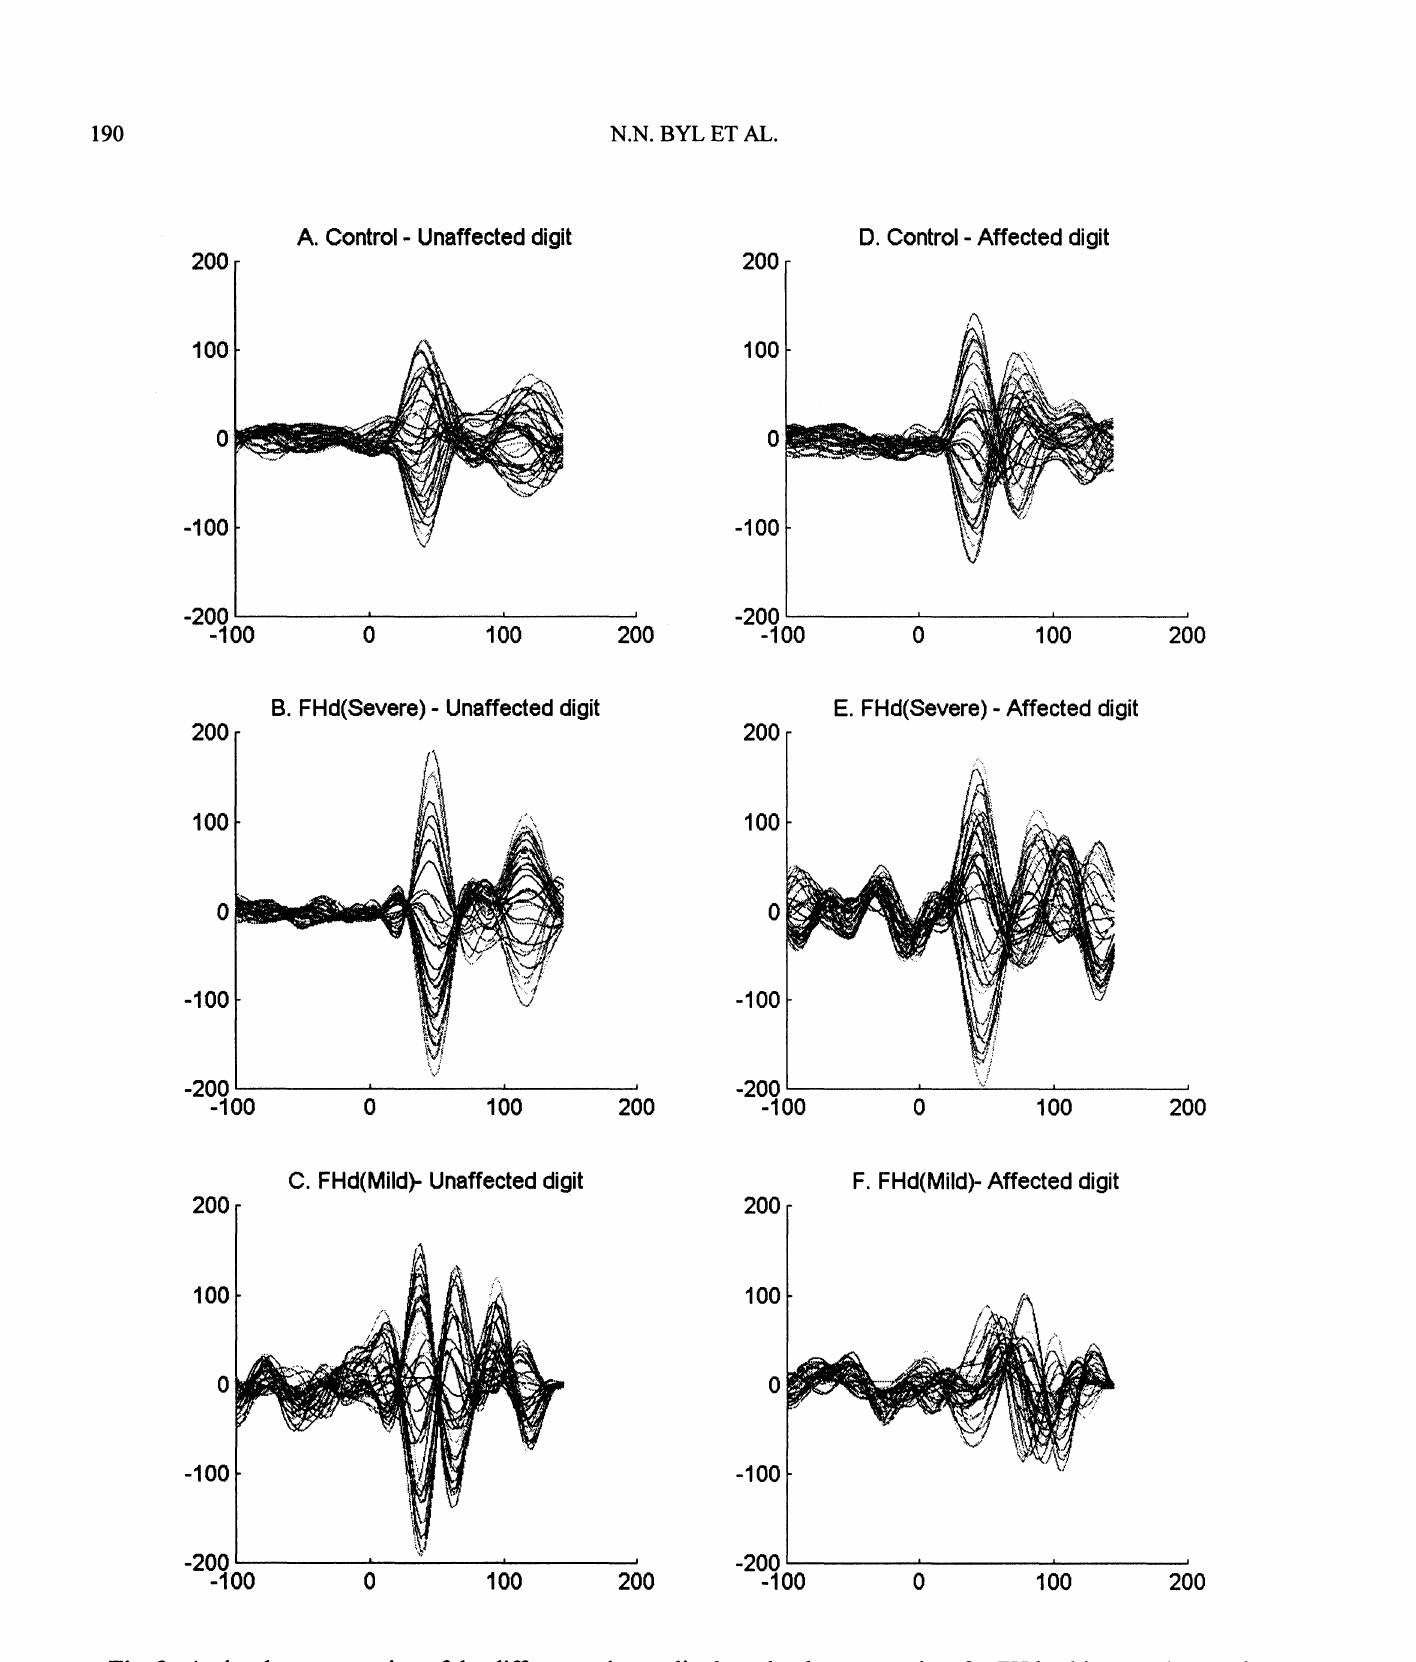
Fig. 2" A visual representation ofthe differences in amplitude and volume over time for FHd subjects and